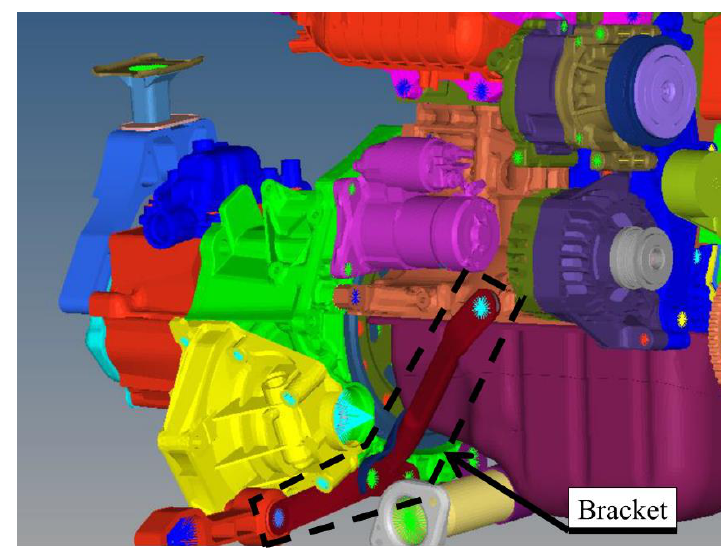
Figure 3. Close up of the crankcase–gearbox bracket under analysis.